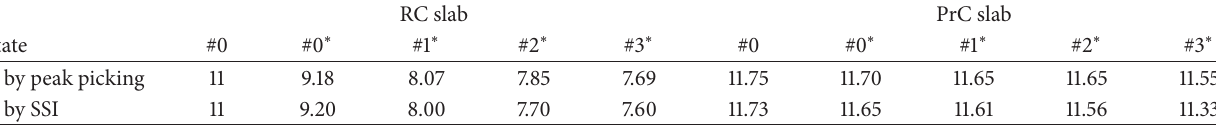
Table 5: The shift of the first eigenfrequency (Hz) from the intact state until before the collapse (always unloaded state).